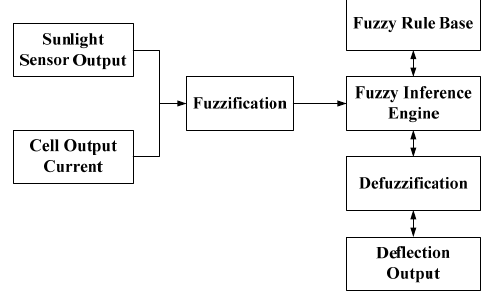
Figure 4. Framework of fuzzy logic control method. Table 2. Fuzzy variables.